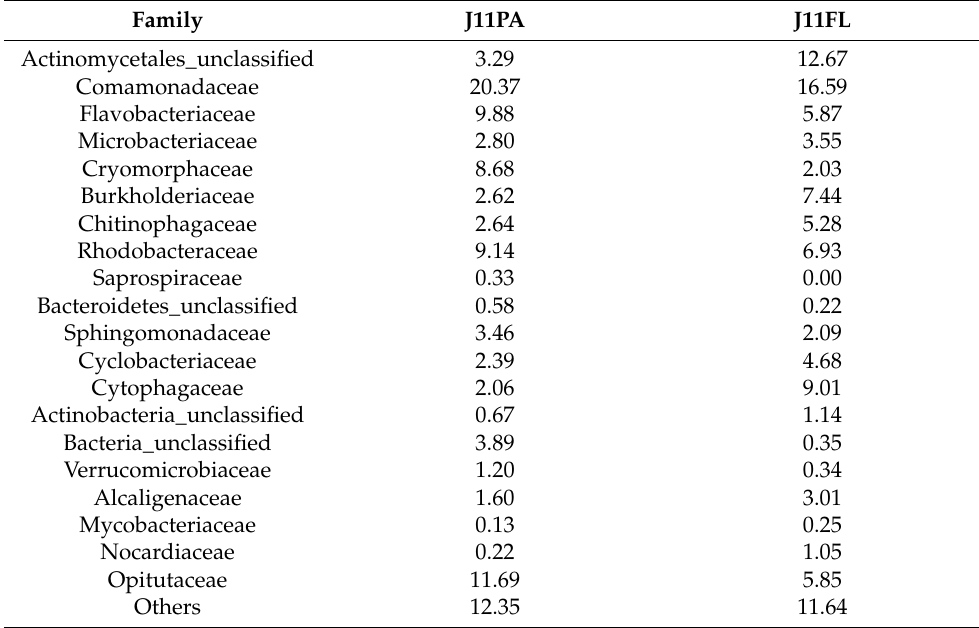
Table A2. Table of bacterial abundance at the family level at point J11.